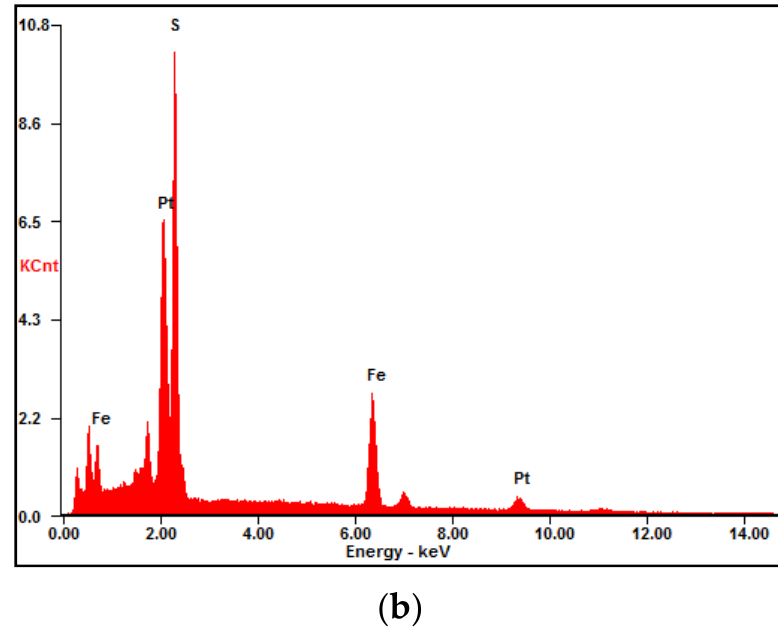
Figure 11. EDS spectrum: ( a ) untreated ore; ( b ) ultrasonically treated ore.